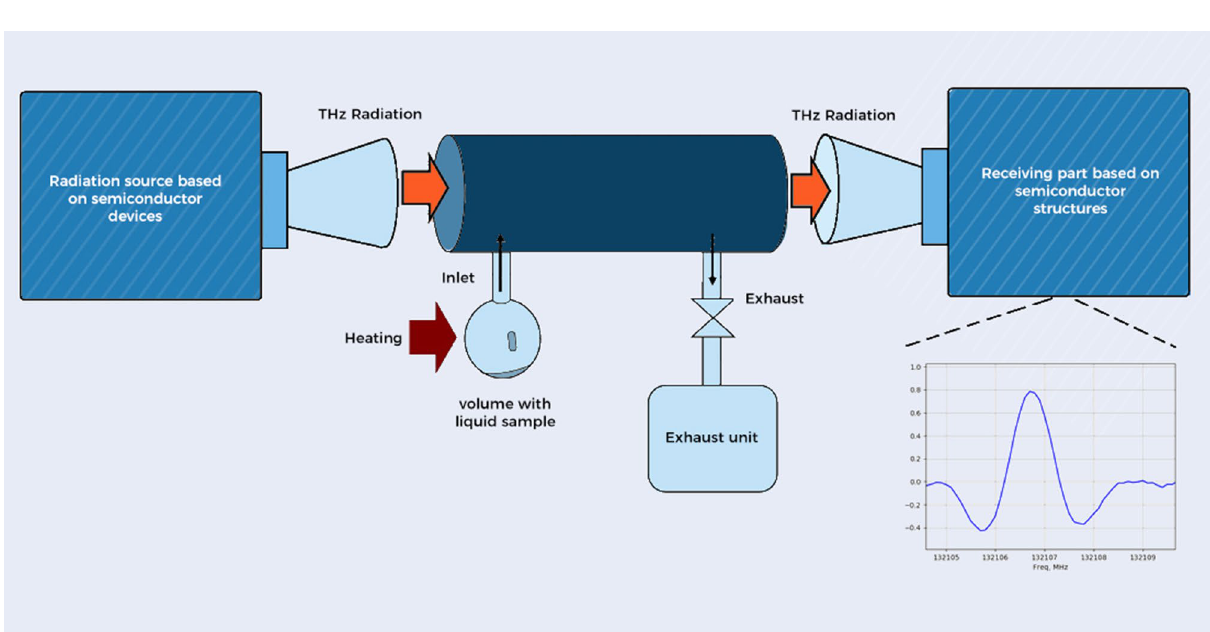
Figure 6. Diagram describing the experimental setup where the radiation source and the receiving part (detection) are based on semiconductor superlattice multipliers and mixers